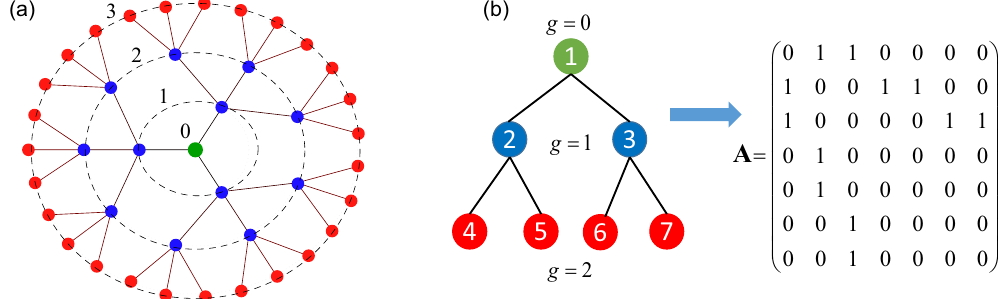
Figure 1. ( a ): Tree network with branching order, d = 3, and G = 3 generations. Peripheral nodes are marked red and receive external excitations. Dashed circles indicate corresponding shells of the tree’s generations, g = 1, 2 and 3; generation g = 0 refers to the central (primary branching) node (green). For a discrete cable model of myelinated dendrites, active elements are nodes of Ranvier, which are connected by passive resistors. ( b ): Adjacency matrix A (right) of a tree network with branching order d = 2 and two generations, G = 2 (left). Numbering of nodes starts with the central node and ends with the peripheral